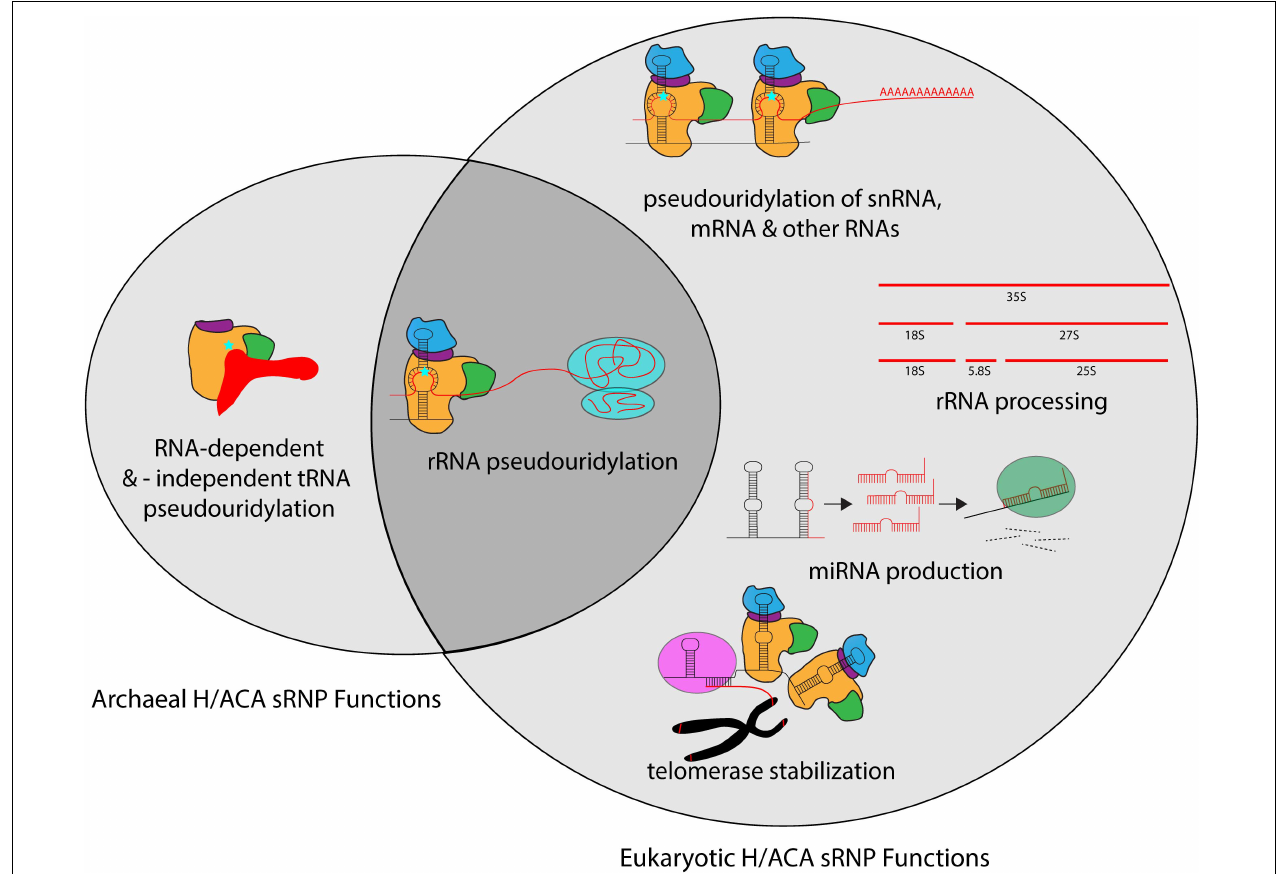
FIGURE 3 | Overview of the different cellular processes that involve H/ACA sRNPs in archaea and eukaryotes. Whereas most known H/ACA sRNPs are responsible for rRNA pseudouridylation, many additional modification targets in snRNAs, mRNAs and other non-coding RNAs have been identified in eukaryotes. In contrast, the archaeal H/ACA proteins are also capable of pseudouridylating tRNA both in a guide RNA-dependent and -independent manner. In addition to the RNA modification activities, eukaryotic H/ACA sRNPs are also implicated in rRNA processing, miRNA production, and telomerase